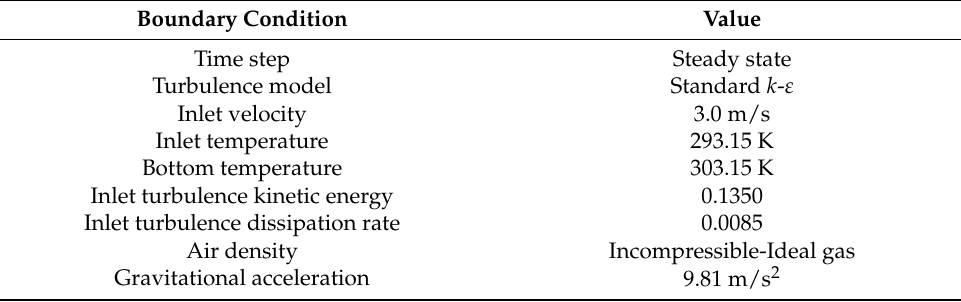
Table 4. The boundary condition of validation model.